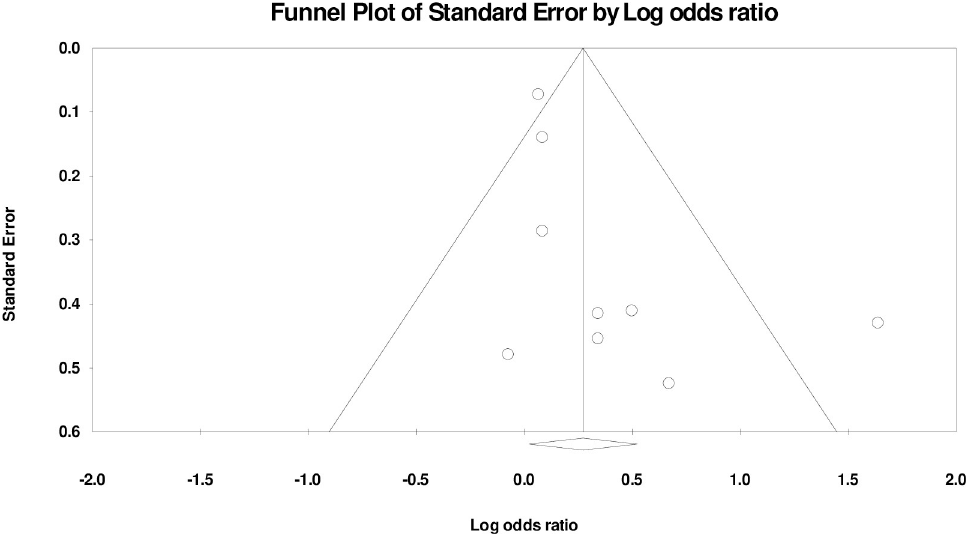
Fig 19. Funnel plot illustrating publication bias assessment of male gender as a risk factor of neonatal sepsis.